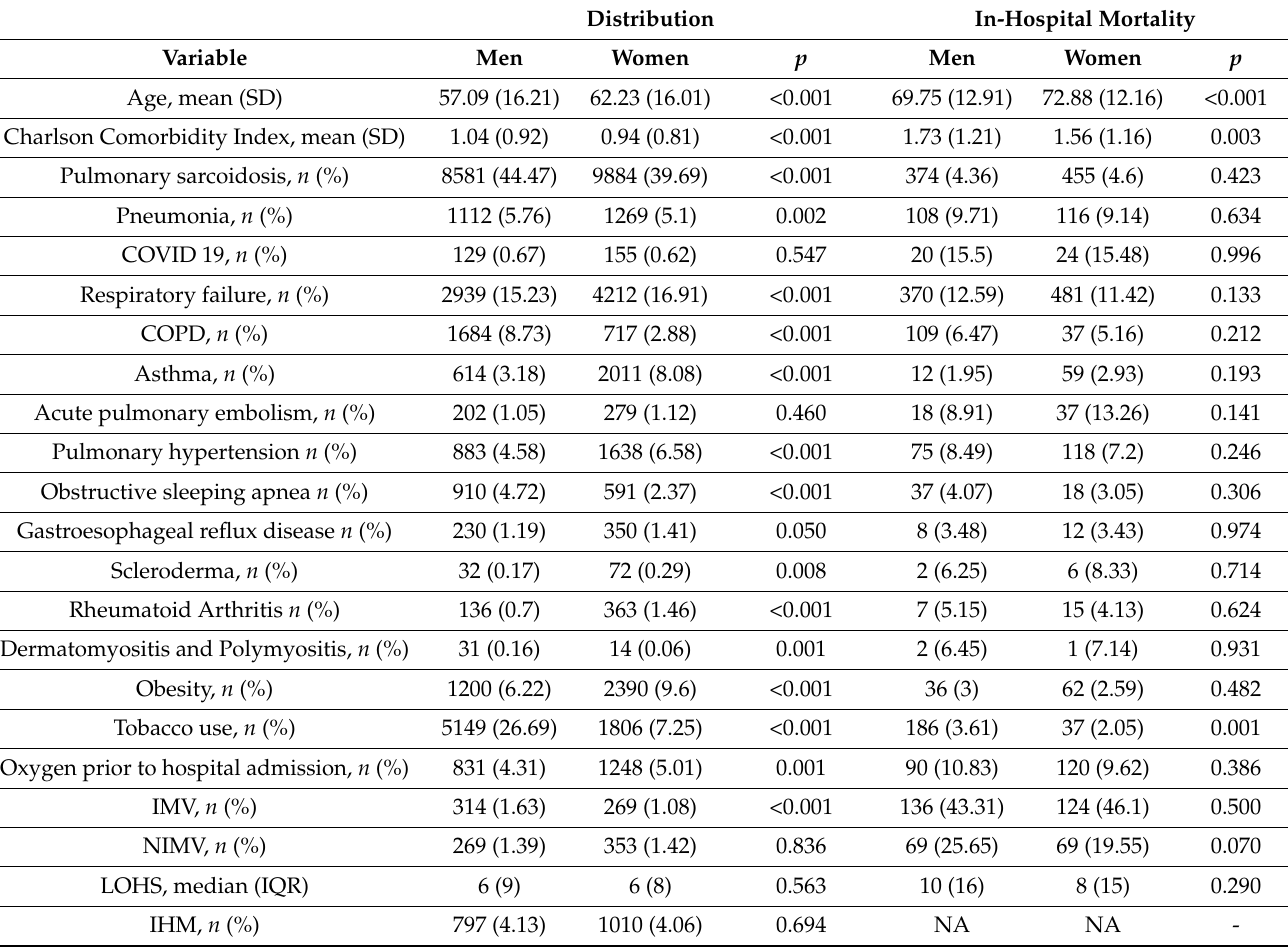
Table 4. Distribution and in-hospital mortality among women and men according to comorbidities, procedures, and in-hospital outcomes among adults hospitalized with sarcoidosis in Spain from 2001 to 2020, according to